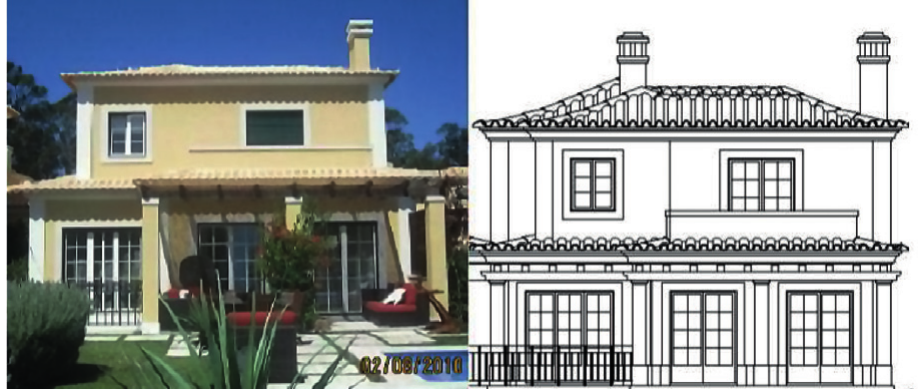
Fig. 1. Photo and view of a façade under analysis (from a CAD